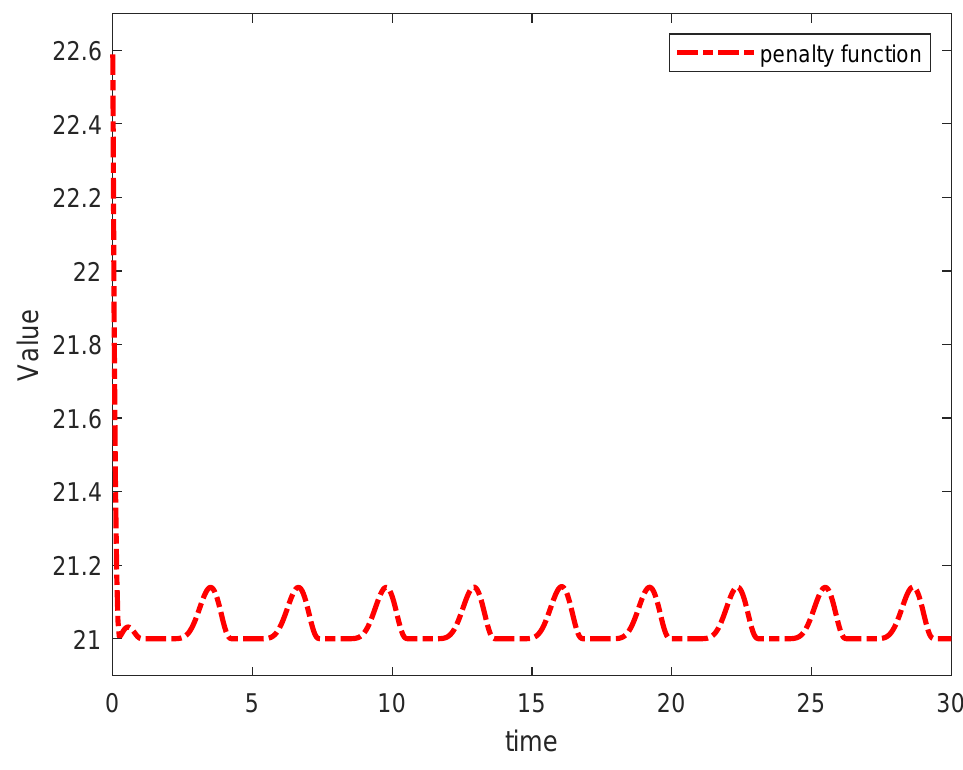
Figure 19. The trajectories of control input u i based on the finite-time distributed algorithm.